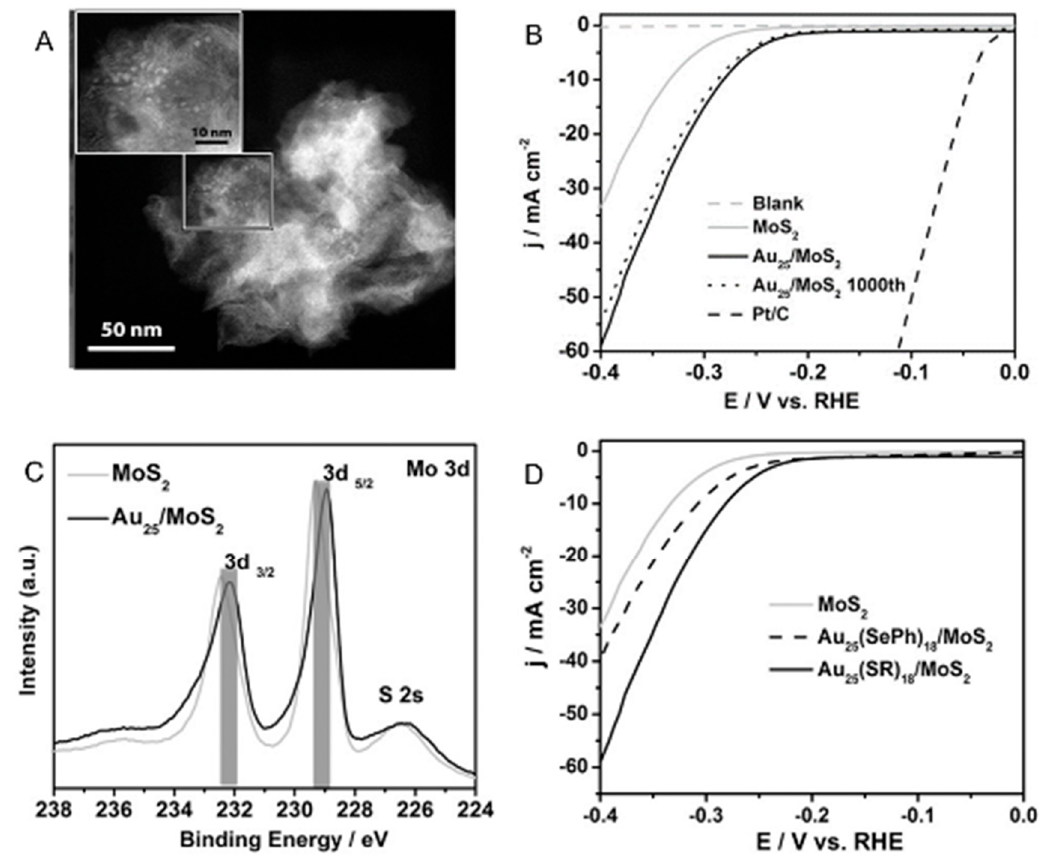
Figure 5. ( A ) High-angle annular dark-field scanning TEM (HAADF-STEM) images, ( B ) HER Figure 5. (A) High-angle annular dark-field scanning TEM (HAADF-STEM) images, (B) HER polarizationcurves, and( C )Mo3dX-rayphotoelectronspectroscopy(XPS)spectraofAu 25 (PET) 18 / MoS 2 . polarization curves, and (C) Mo 3d X-ray photoelectron spectroscopy (XPS) spectra of ( D ) HER polarization curves of Au 25 (SePh) 18 / MoS 2 . Panels ( A – D ) are reproduced with permission Au 25 (PET) 18 /MoS 2 . (D) HER polarization curves of Au 25 (SePh) 18 /MoS 2 . Panels (A − D) are reproduced from reference [108]. Copyright Wiley-VCH, with permission from reference [108]. Copyright Wiley-VCH, 2017.